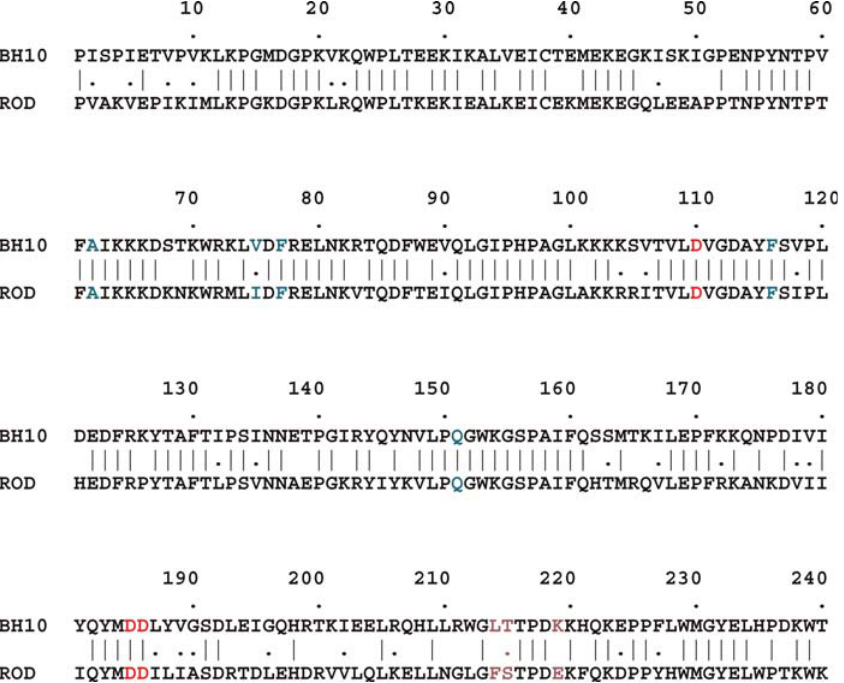
Figure 4. Comparison of the First 240 Amino Acids of HIV-1 RT (Strain BH10) and HIV-2 RT (Strain ROD) The triad of aspartic acid residues critical for polymerase activity is shown in red. The amino acid residues that are altered as part of the Q151M complex in HIV-1 RT are shown in blue; residues 214, 215, and 219 are shown in plum. DOI: